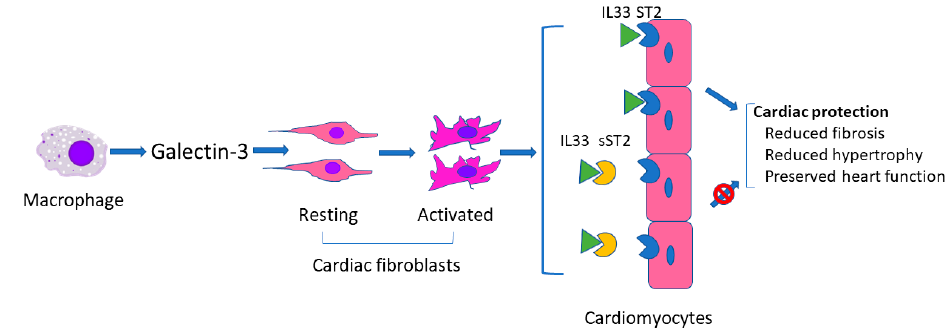
Figure 1. Schematic of possible mechanism of galectin 3 and sST2 in heart failure.